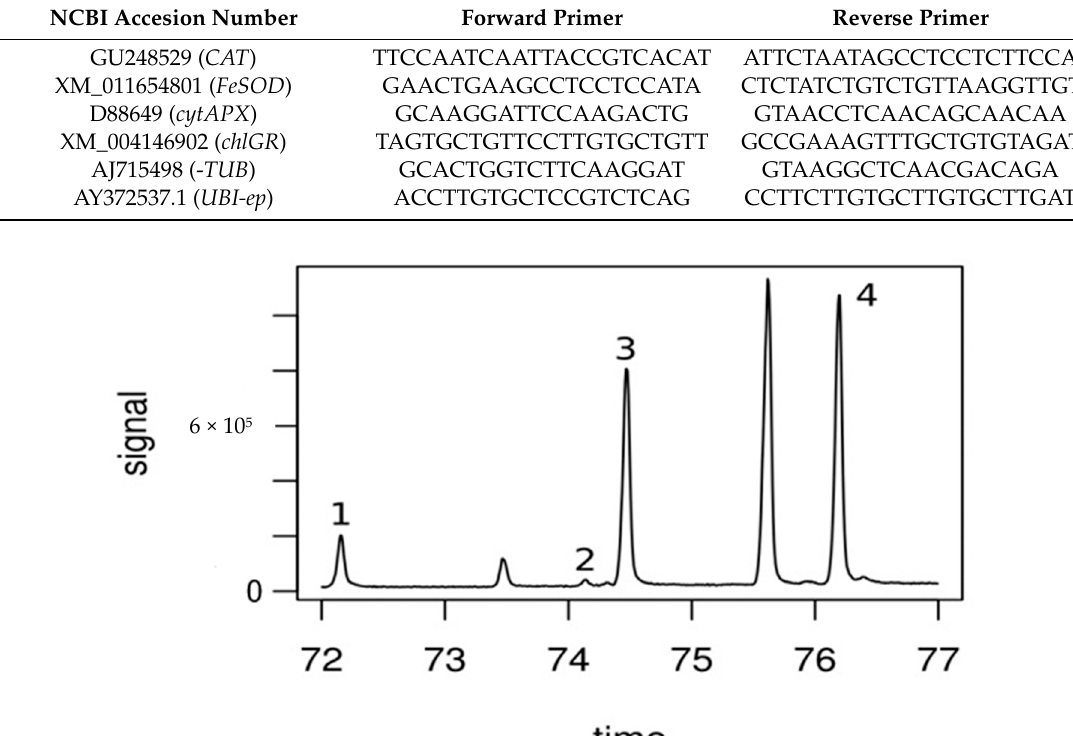
Figure A3. An exemplary GC-MS chromatogram of tocopherols. 1—d-tocopherol, 2—b-tocopherol,